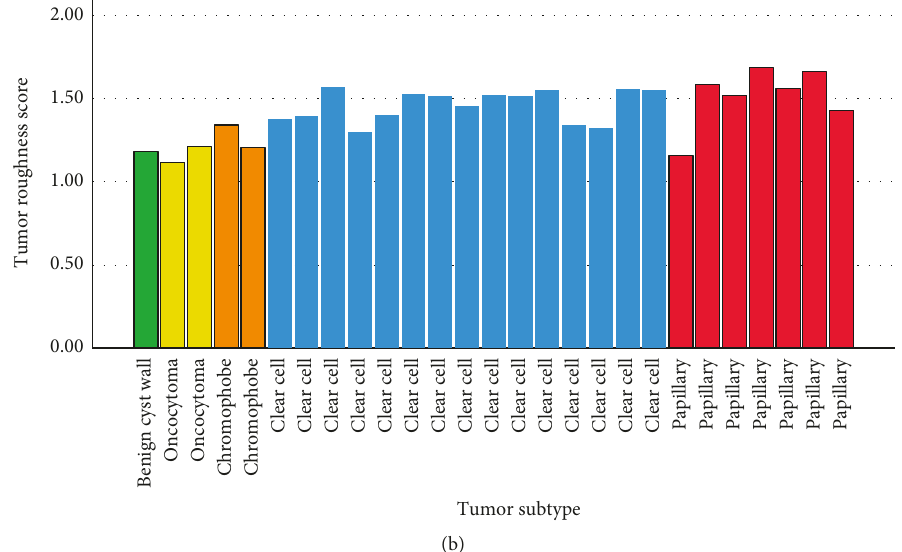
Figure 3: (a) Box and whisker plot displaying the tumor surface roughness score compared to each renal mass subtype for trend. (b) Waterfall plot for tumor roughness score with each renal tumor subtype listing less aggressive tumors to the left and more aggressive tumors to the right.